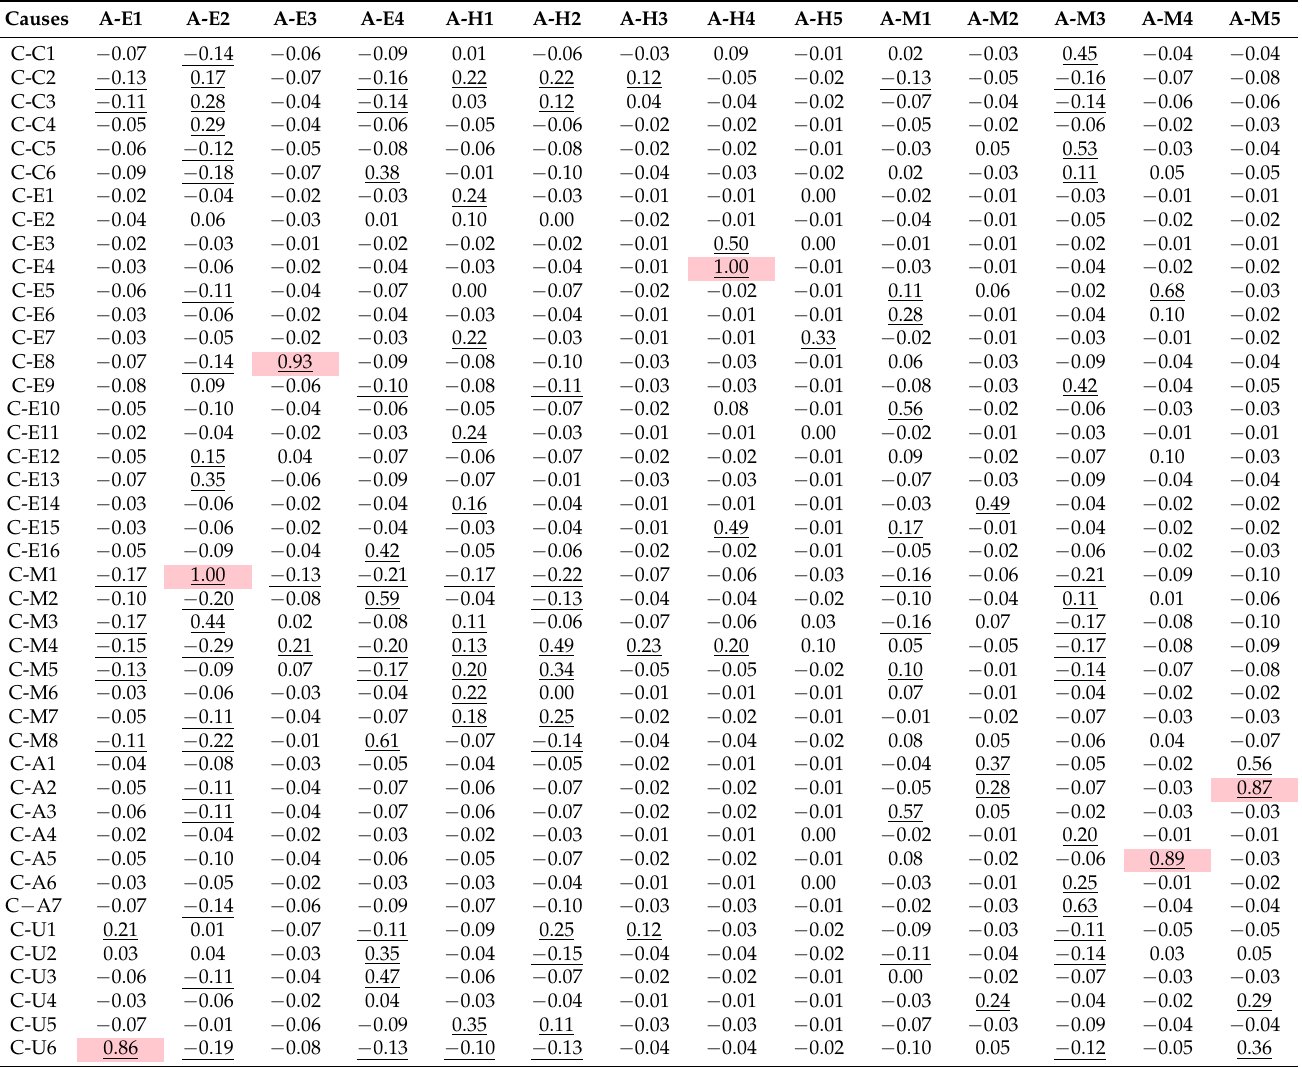
Table 3. Linear correlation between causes and